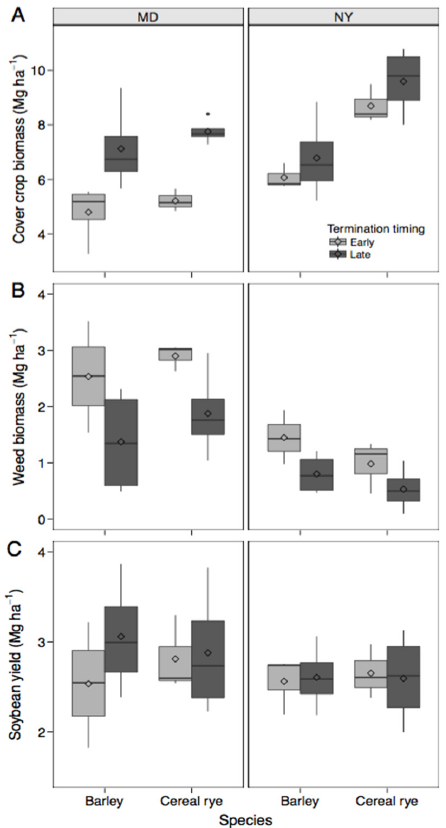
Figure 3. The impact of cover crop termination timing on cover crop biomass ( A ), weed biomass ( B ) and soybean grain yield ( C ) using six-row winter barley and cereal rye cover crops in Maryland (MD) and New York (NY) in 2014. Late termination timing occurred one week after the early date. Box plots represent the mean (open diamond symbol), median (horizontal line), interquartile range (box) and the maximum and minimum values (end of each vertical line). For each response, species and termination timing were included as fixed effects: cover crop biomass ( F 1,25 = 12.68, p = 0.0015 for species and F 1,25 = 12.33, p = 0.0017 for termination timing); weed biomass ( F 1,25 = 0.032, p = 0.86 for species and F 1,25 = 11.65, p = 0.0022 for termination timing); and soybean yield ( F 1,20 = 0.0041, p = 0.95 for species and F 1,20 = 0.90, p = 0.35 for termination